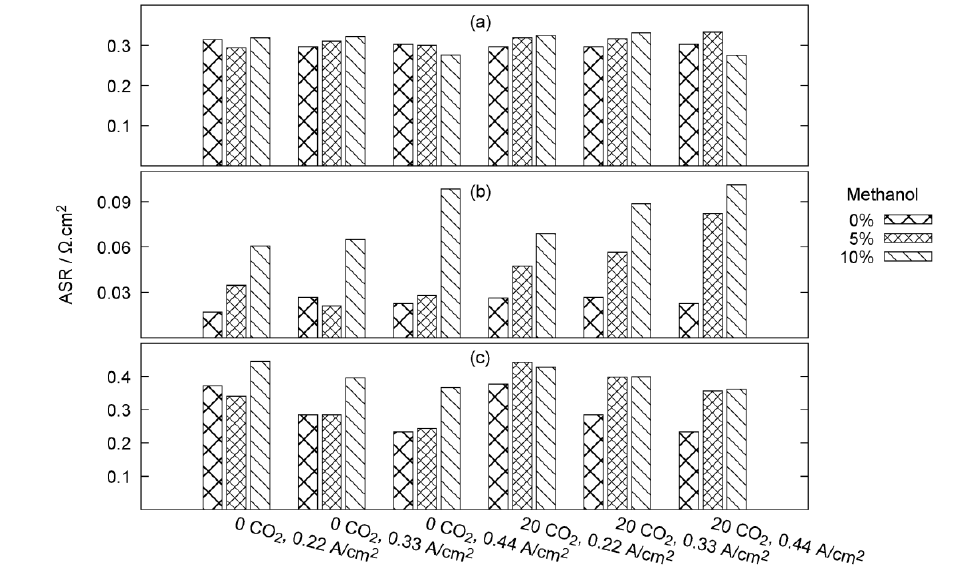
Figure 7. The effect of methanol on a PBI-based HT-PEMFC operating at 160 °C with content and current density. ( a ) Ohmic resistance; ( b ) High frequency changing CO 2 resistance; ( c ) Intermediate -low frequency